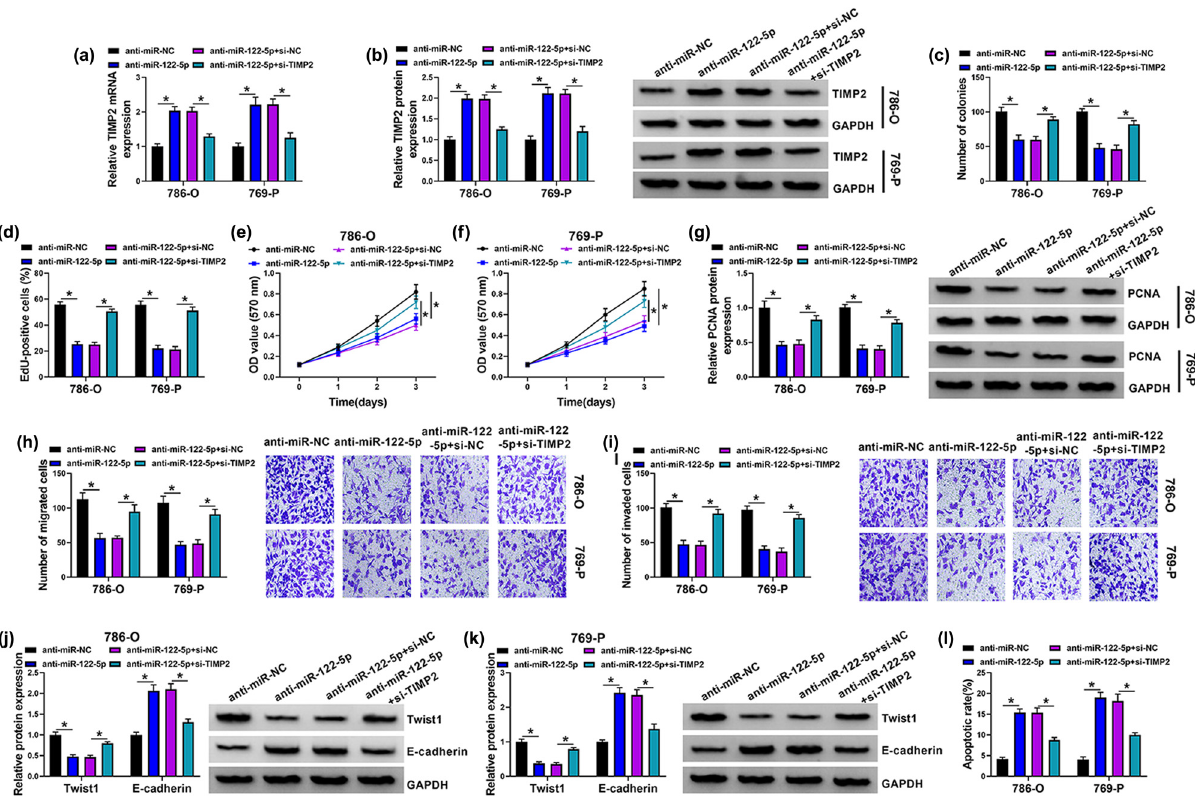
Figure 6: miR - 122 - 5p/TIMP2 regulates progress of ccRCC cells. ( a ) qRT - PCR detected the expression of TIMP2. ( b ) Western blot detected the expression of TIMP2 protein. ( c ) Colony formation assay detected the number of colonies. ( d ) EdU assay detected the EdU - positive cells. ( e and f ) MTT detected the cell viability. ( g ) Western blot detected the level of PCNA protein. ( h and i ) Transwell assay detected the cell migration and invasion ability. ( j and k ) Western blot detected the level of Twist1 and E - cadherin. ( l ) Cell apoptosis was detected by fl ow cytometry. * P <